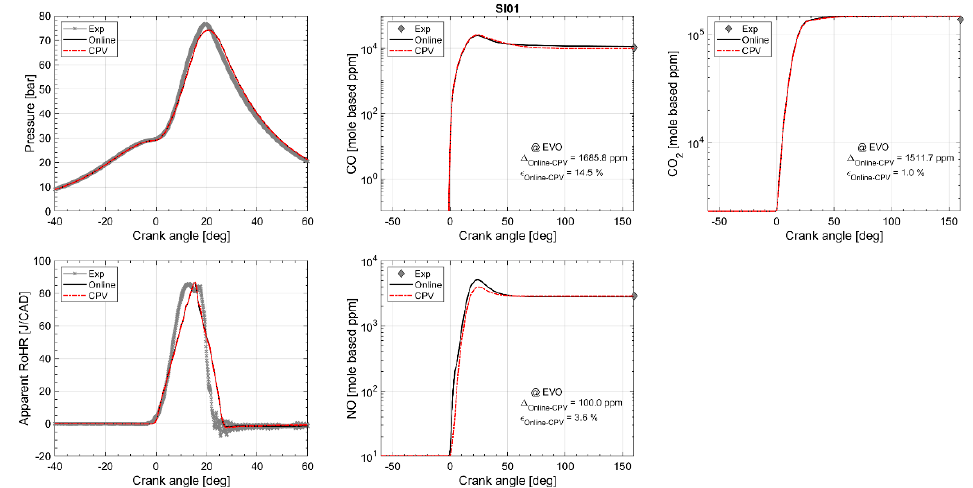
Figure A11. Engine performance and emissions for operating point SI01 (1500 rpm, 15.0 bar IMEP).